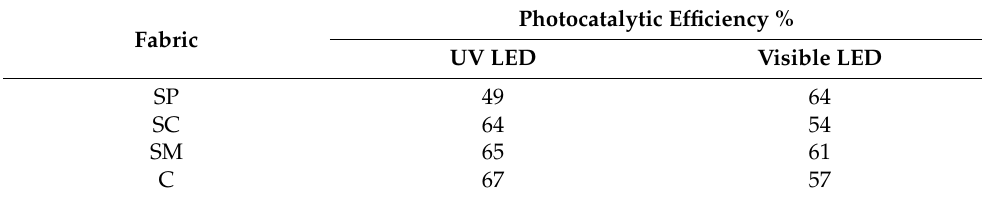
Table 7. Effect of fabric substrates. Tests carried out with TACR at T ◦ = 25 ◦ C, under both UV and visible light